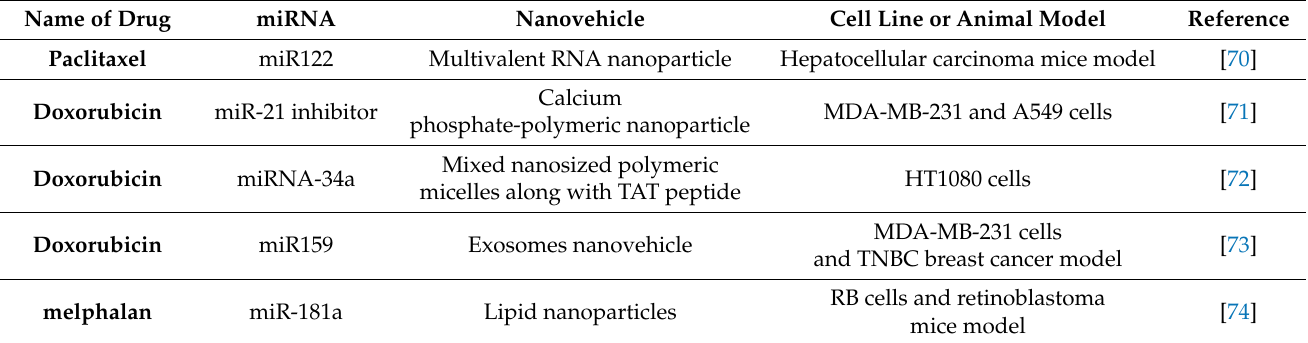
Table 2. Nanomedicine-based system for co-delivery of miRNA and chemotherapeutic